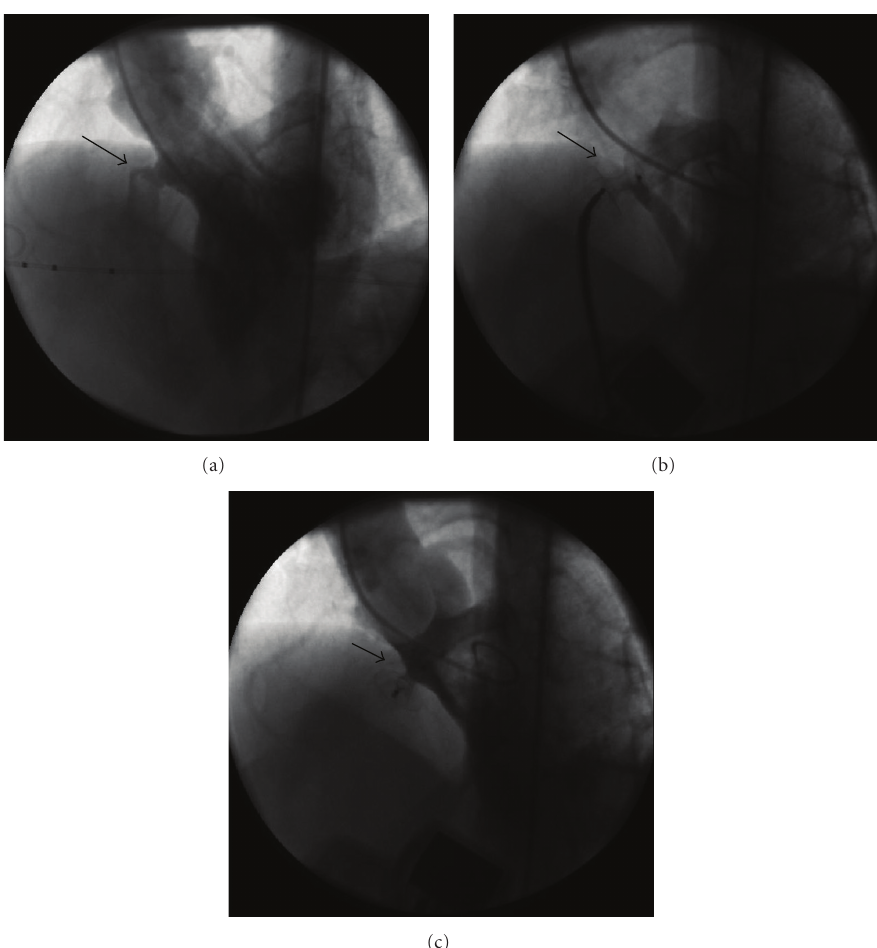
Figure 1: (a) Muscular VSD before the closure, (b) muscular VSD during the occluder device positioned, (c) muscular VSD successfully occluded by the device after